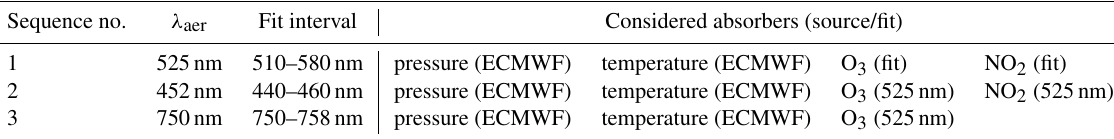
Table 2. Sequence and settings of ONPD retrieval. Sequence